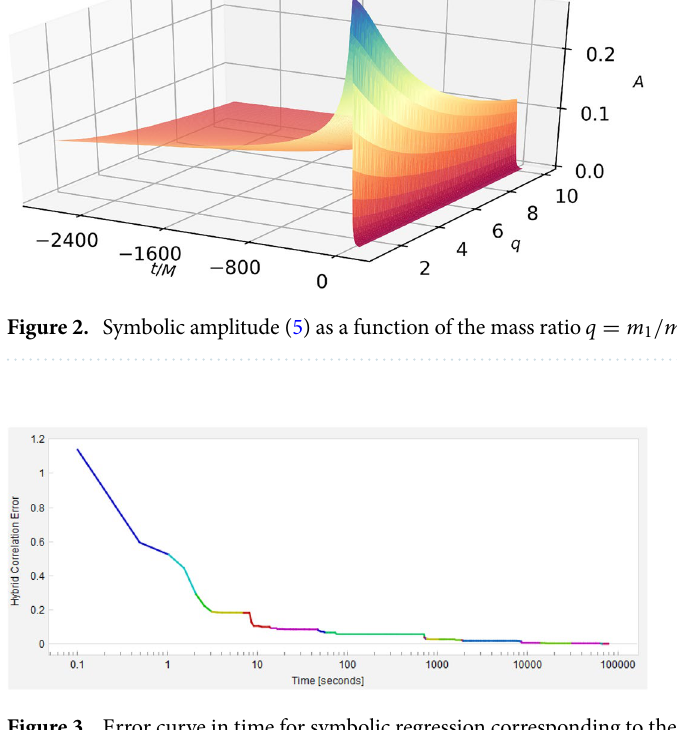
Figure 3. Error curve in time for symbolic regression corresponding to the amplitude. Note the error in a few seconds reaches a plateau. We stopped our search when the symbolic waveforms reached a 99% overlap with respect to the surrogate